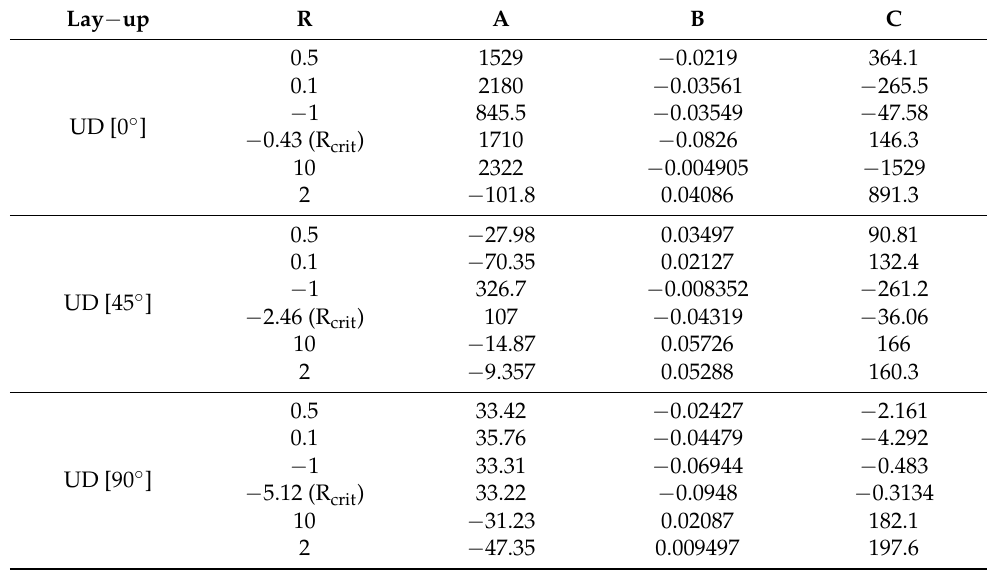
Table 4. The fitting parameters of the Equation (3) for the input S-N curves.